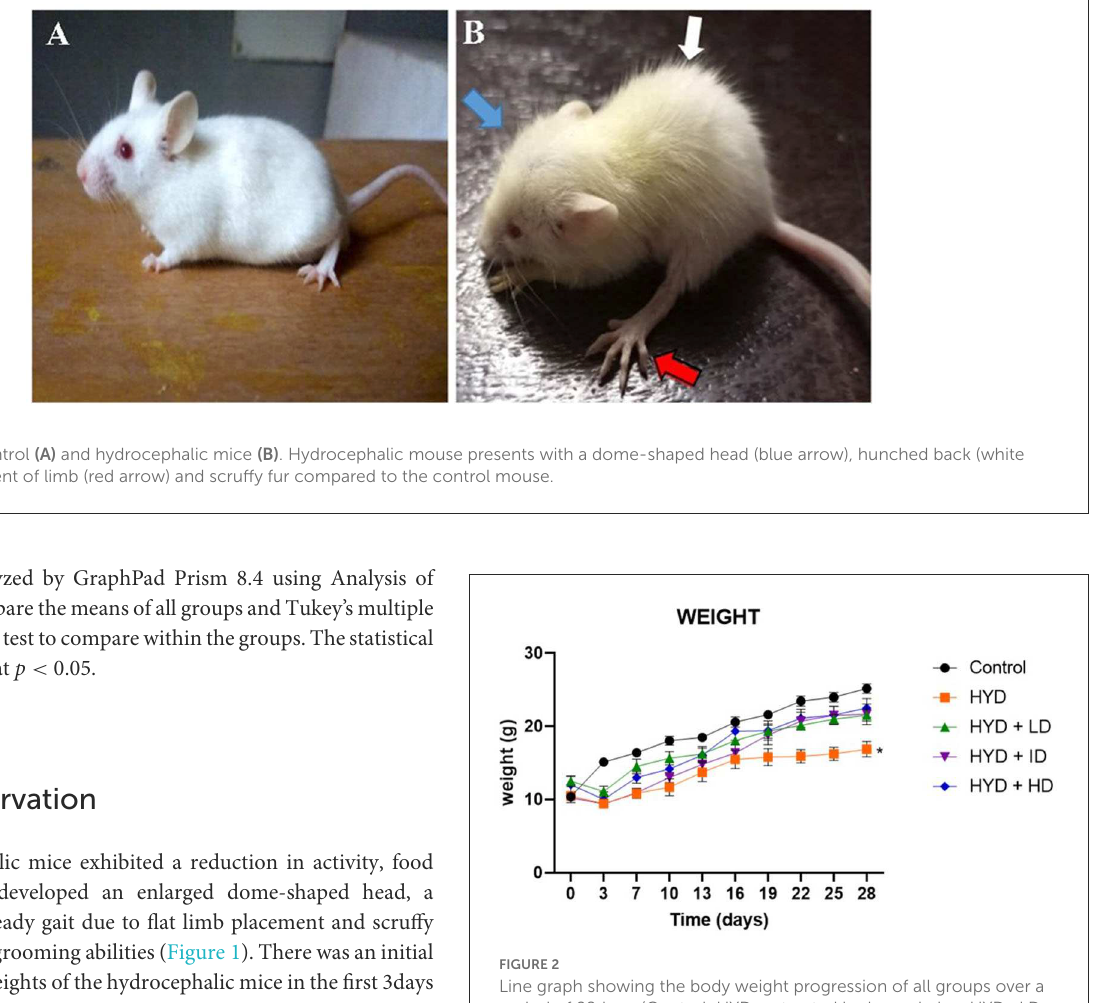
FIGURE2 Line graph showing the body weight progression of all groups over a period of 28days. (Control; HYD, untreated hydrocephalus; HYD + LD, hydrocephalus + low dose vanadium; HYD + ID, hydrocephalus + intermediate dose vanadium; HYD + HD, hydrocephalus + high dose vanadium; * p < 0.05; p =